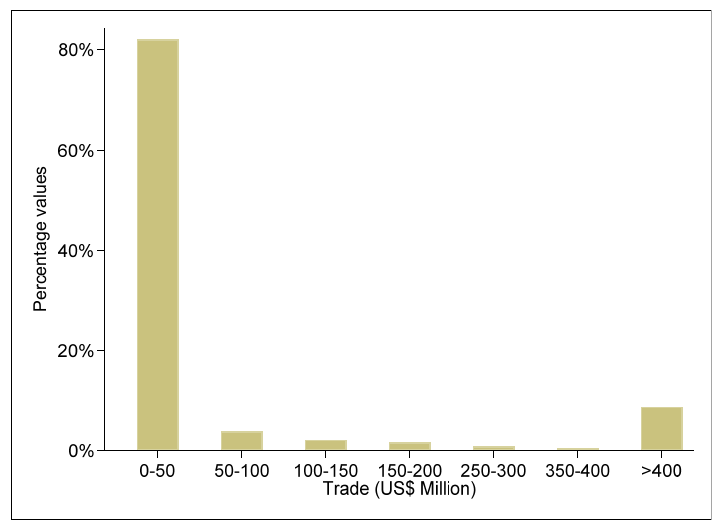
Figure 3. Distribution of non-renewable energy export values by percentage. Source: Authors’ elaboration based on data retrieved from CEPII database.